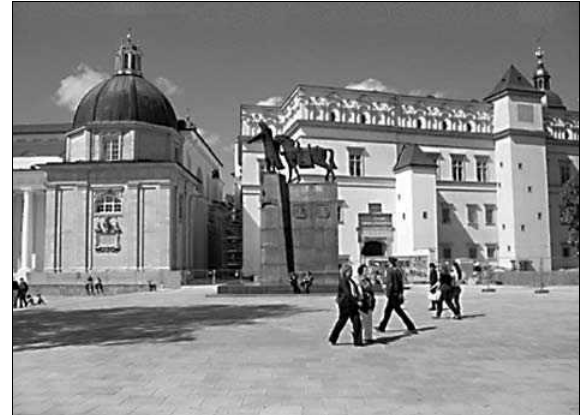
Fig. 1. Grand Duke Gediminas Monument on arkikatedra Square, Vilnius (sculpt. V. kašūba, archit. h. k. Šilgalis), 1996.